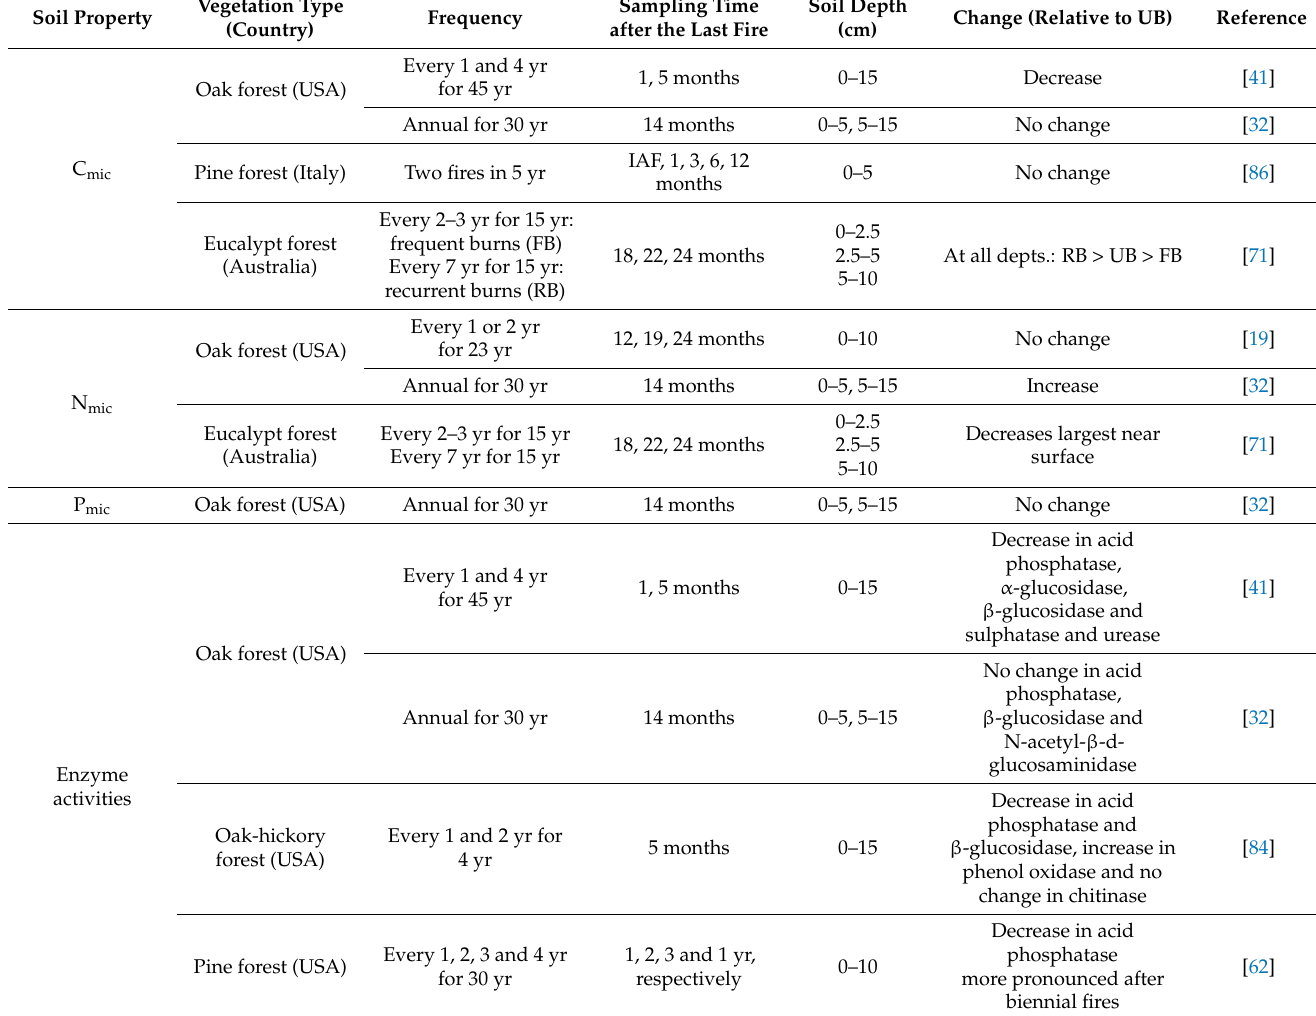
Table 8. Studies including the effects of repeated prescribed fires on soil biochemical and microbial properties: microbial biomass C (C mic ), microbial biomass N (N mic ), microbial biomass P (P mic ), enzyme activities, soil respiration, community level physiological profiles (CLPP), phospholipid fatty acid (PLFA), soil fungal community composition and structure and bacterial community diversity. UB: unburned soil; yr: year; IAF: immediately after